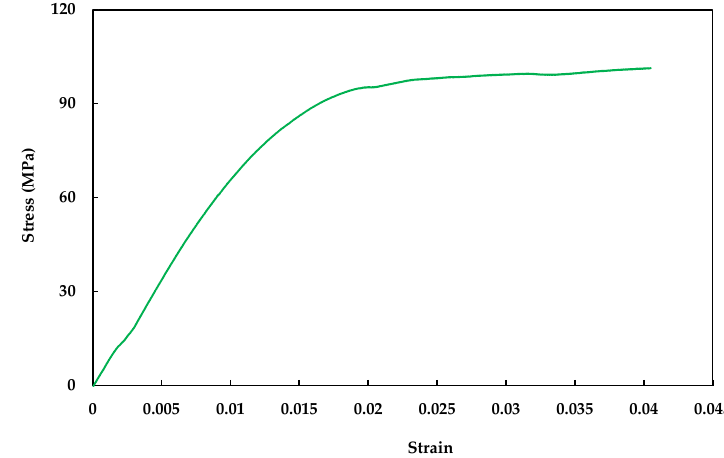
Figure 1. Stress-strain behavior of the polyester FRP composite.